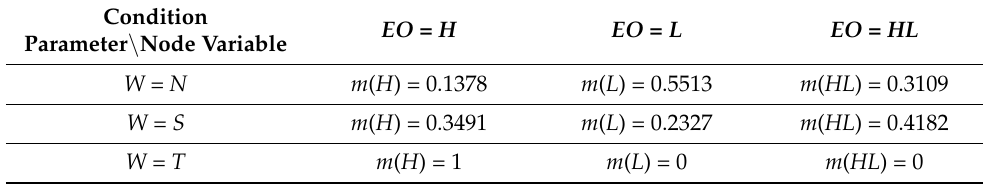
Table 3. Conditional belief parameters of node EO